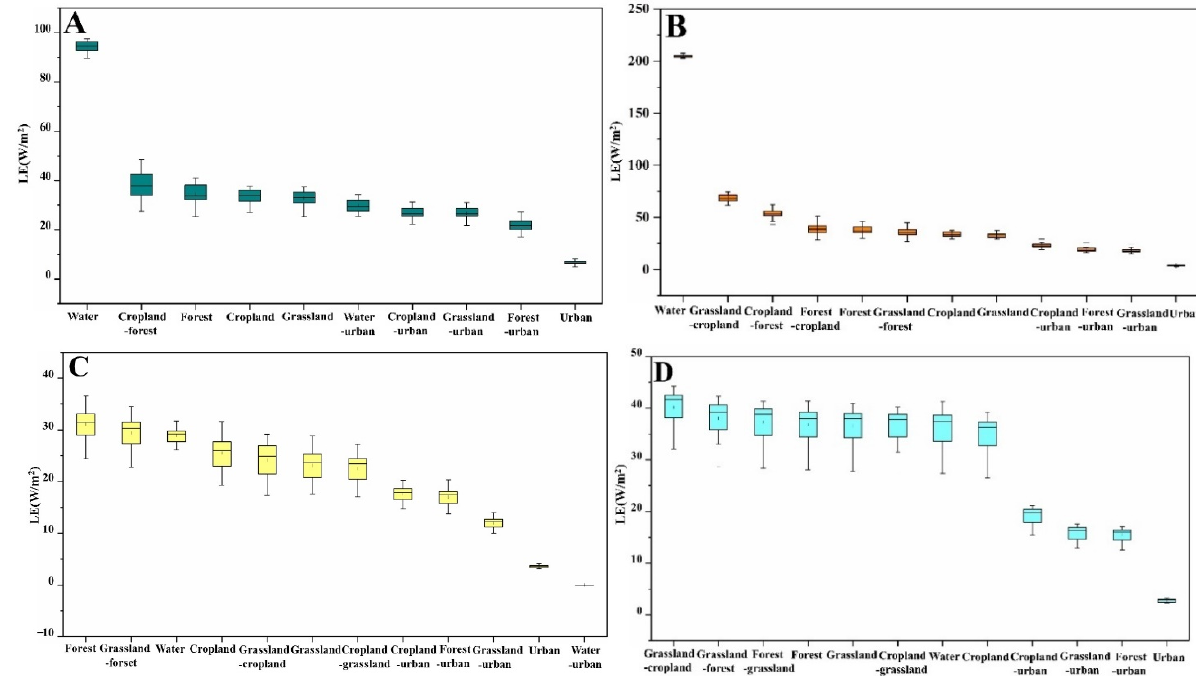
Figure 15. Statistical characteristic values of LE based on different land types from 2000 to 2015 (( A ): Jinan City, ( B ): Zhengzhou City, ( C ): Lanzhou City, ( D ): Xining City).